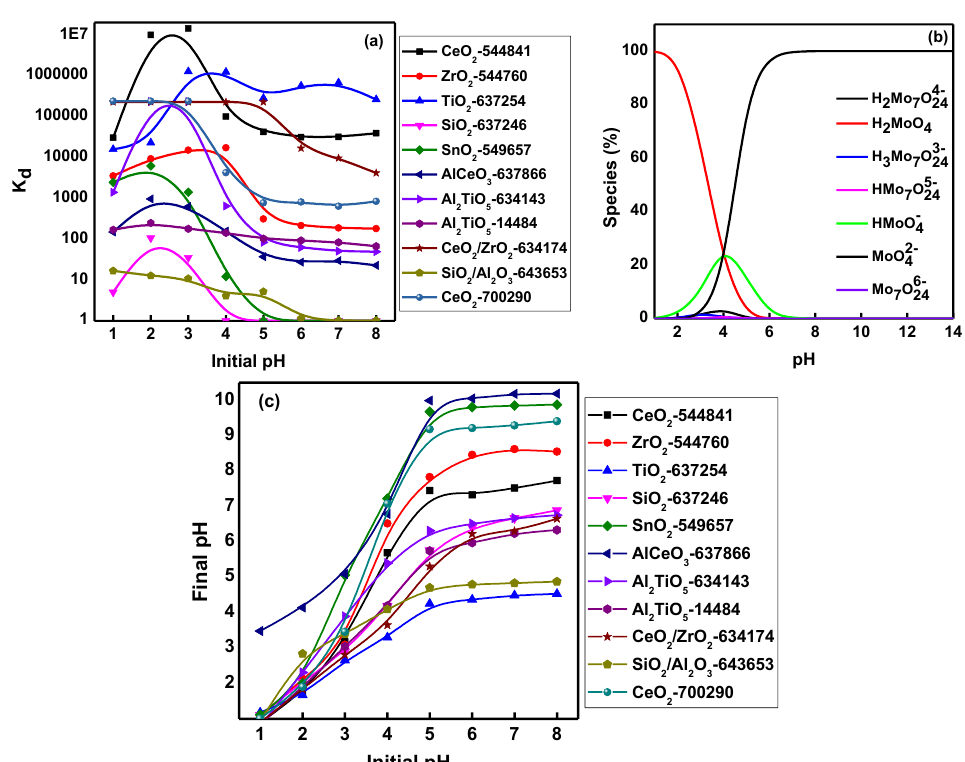
Figure 1. Effect of initial pH on ( a ) the distribution coefficients (K d ) of CA- 99 Mo on different metal oxides NPs (C 0 = 50 mg ∙ L – 1 , V/m = 100 mL ∙ g – 1 , and temperature = 298 ± 1 K), ( b ) Speciation of molybdenum [22], and ( c ) variation of the final pH values.